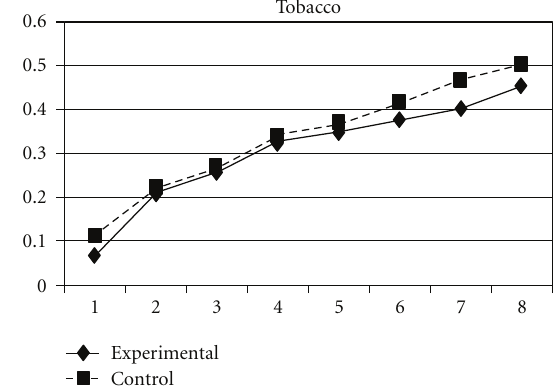
Figure 13: Growth trajectories of the experimental group (all par- ticipants) and control group using the item score of heroin use as the outcome indicator.